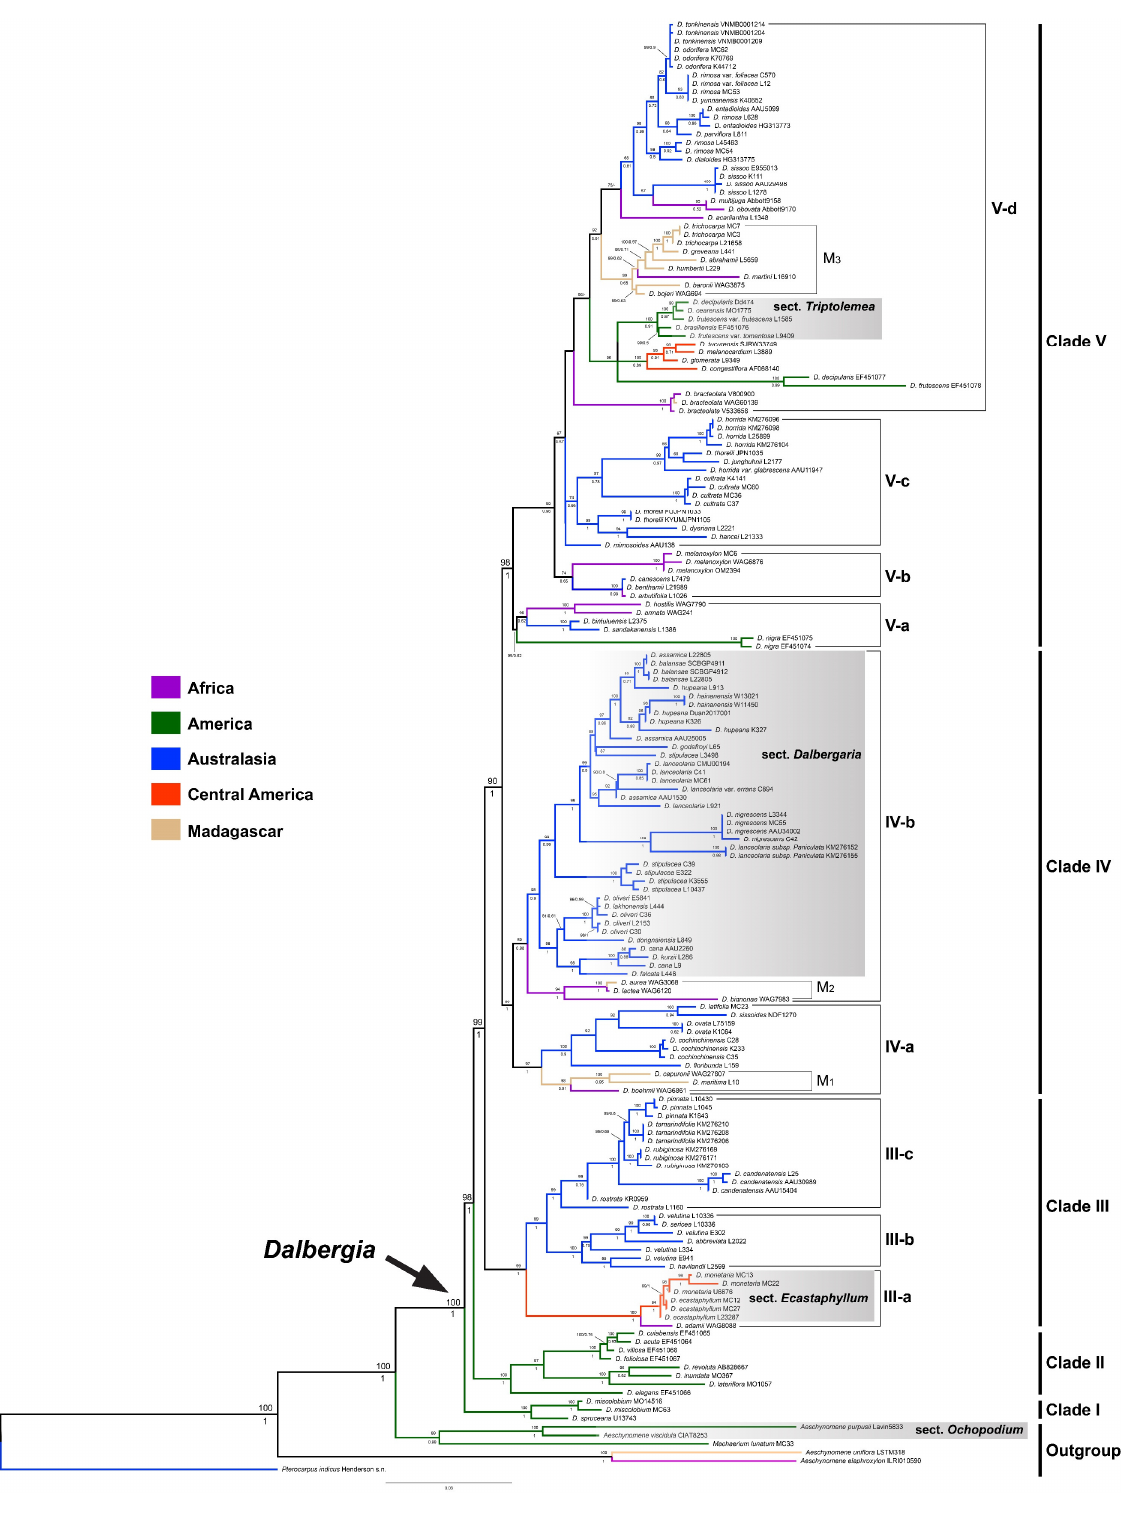
Figure 1. Majority rule consensus tree inferred from the ML analysis based on the concatenated data matrix ( mat K, rbc L and ITS) showing the relationships among 93 species of Dalbergia and 6 outgroups. M 1 , M 2 , and M 3 represents the Madagascar clades. Numbers along branches are ML bootstrap values (up) and BI posterior probabilities (down), respectively. A dash means the topology is not supported by the BI tree. Values <50% and <0.5 are not shown.